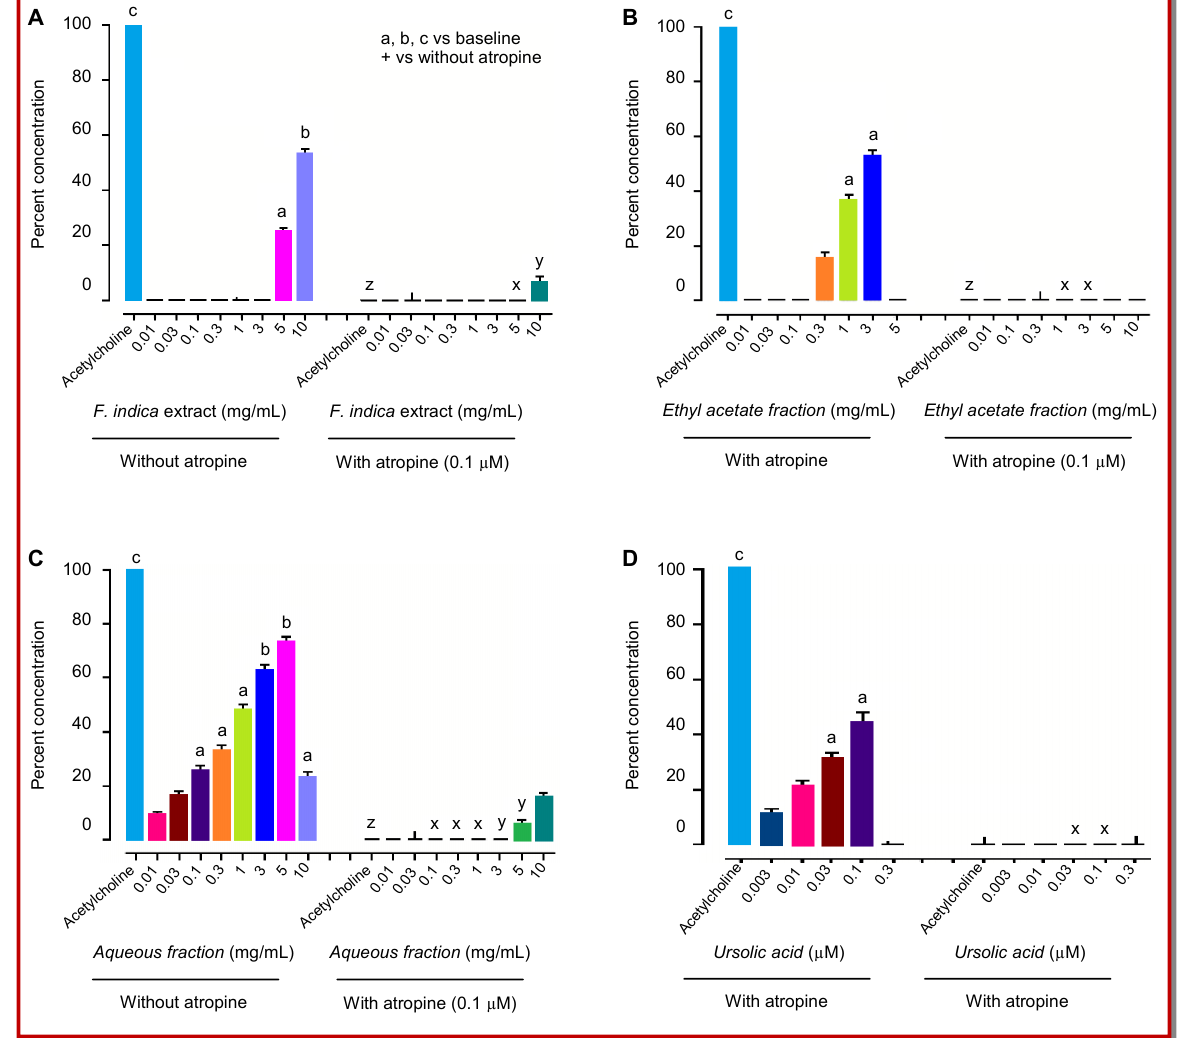
Figure 1: The concentration-dependent stimulatory effect of the crude extract of Fagonia indica (A) its ethyl acetate; (B) aqueous fractions; (C) and ursolic acid; (D) without and with atropine (0.1 μ M) in isolated rat ileum. Values are expressed as mean ± SEM, n= 4-6. a / x p<0.05, b / y p<0.01 and c / z p<0.001. “ a, b, c ” show comparison with baseline (One -way ANOVA tailed with Dunnett's test). “ x, y, z” show comparison of atropine pretreated vs. without atropine pretreated groups (One-way ANOVA tailed with Bonferroni